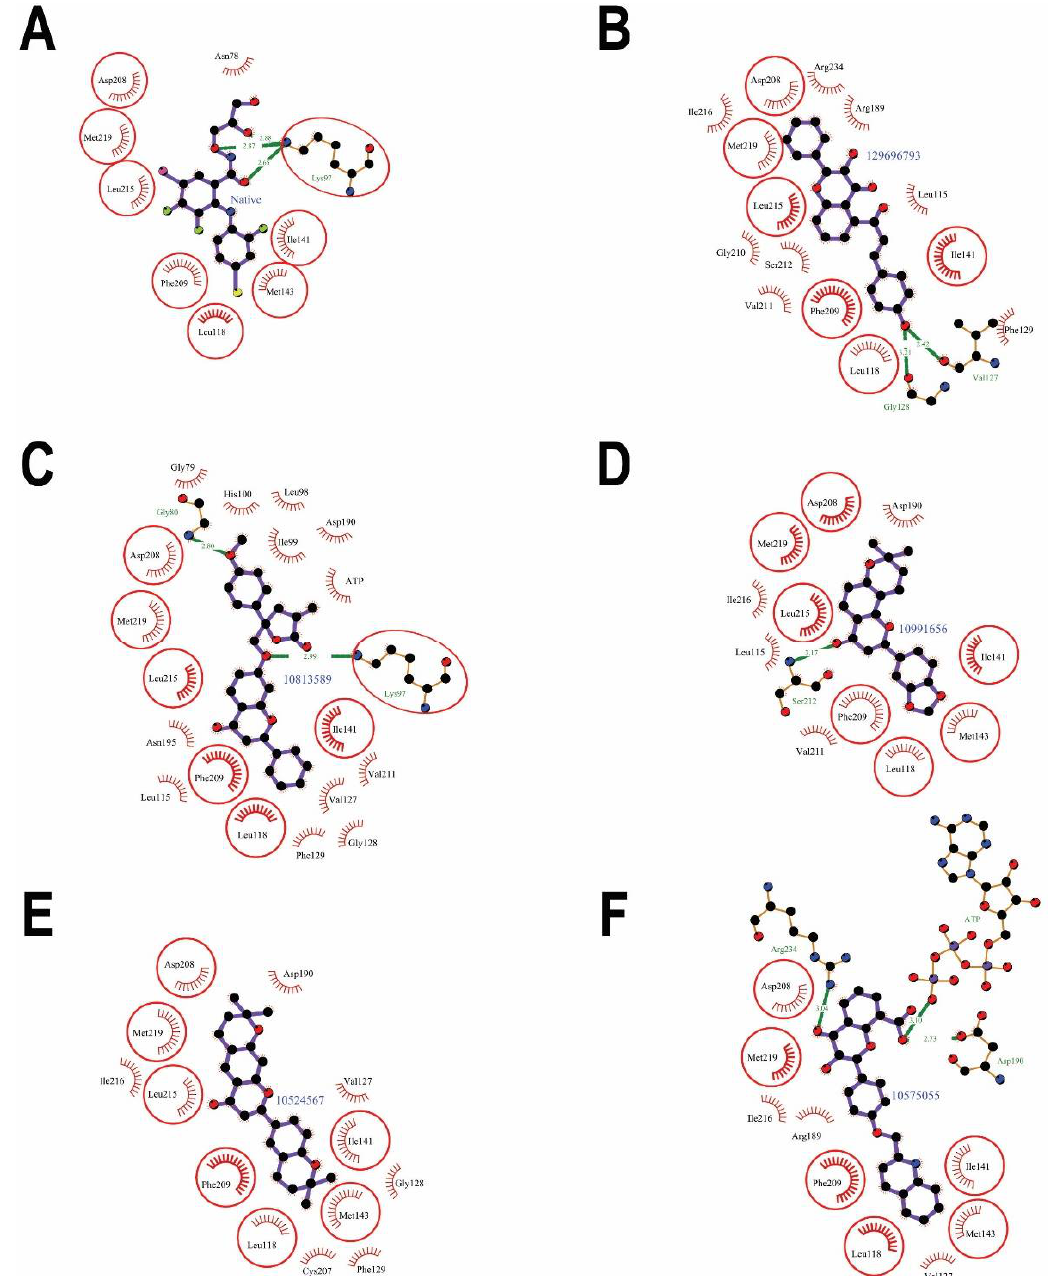
Figure 4. MEK1 protein–ligand interaction plots of native inhibitor ( A ) and selected flavonoids ( B – F ). The residues forming non-bonding interactions are shown as red bristles, while residues forming hydrogen bond and the bound ligand are shown as ball-and-stick representations. The carbon atoms are shown as black balls, nitrogen atoms as blue balls, oxygen atoms as red balls, fluorine atoms as green balls, bromine atom as pink balls, and iodine atom as a yellow ball. The interacting residues common with those of the native inhibitor are shown in circles. The hydrogen bonds are shown as green dashed lines labeled with bond length (in Å).